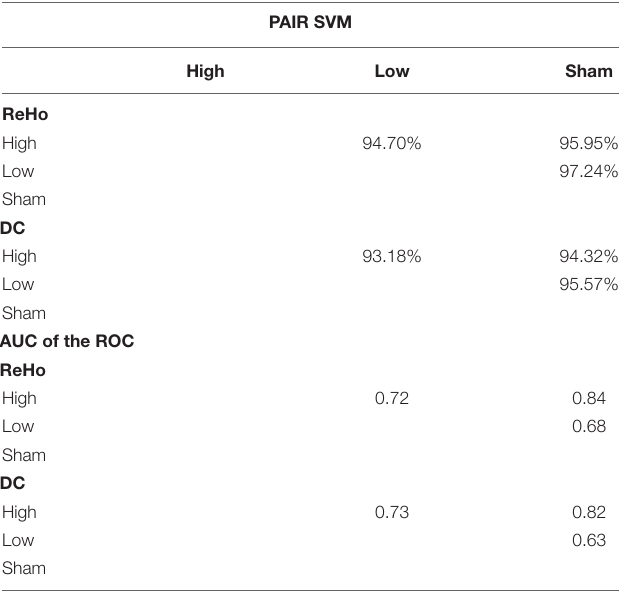
TABLE 4 | The mean classification accuracy of split-half validation and the area under the curve (AUC) of the receiver operating characteristic (ROC) of the peak voxels of the F map of ReHo and DC for pairwise comparison between rTMS